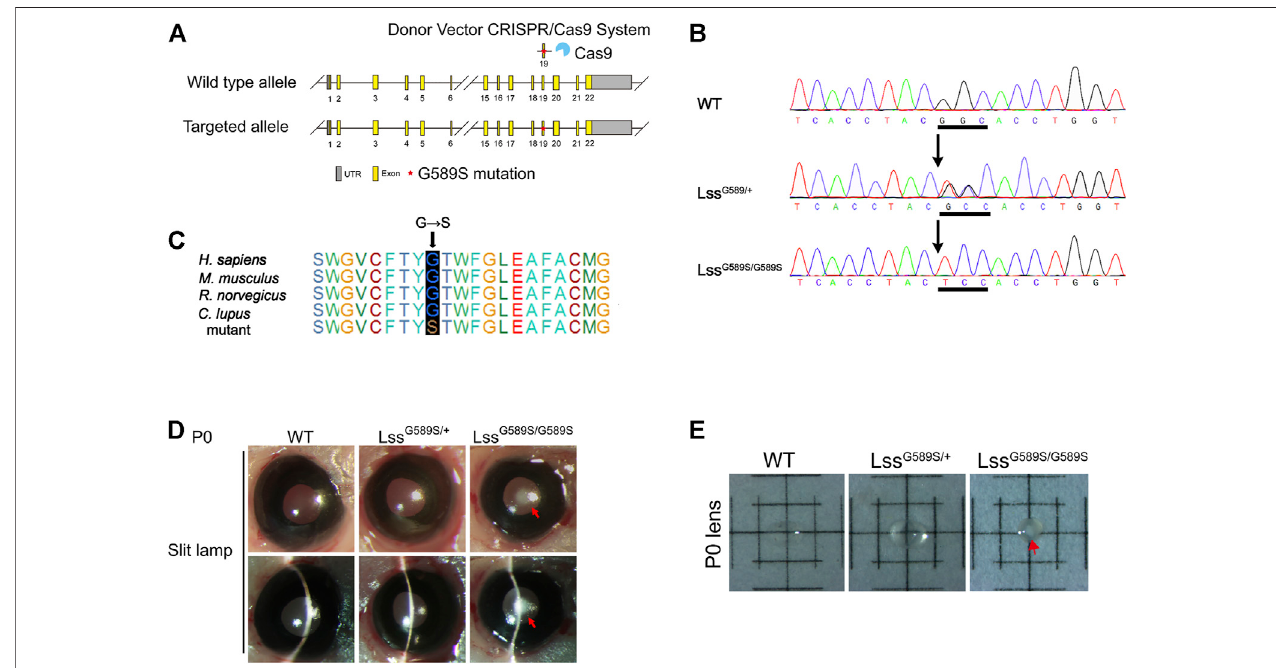
FIGURE 1 | The lens of engineered Lss G589S/G589S mice could recapitulate the phenotype of human congenital cataract. (A) Schematic diagram of Lss G589S knock-in mice generated at exon 19 of Lss via the CRISPR/Cas9 system. (B) Sanger sequencing performed to validate the G589S missense mutation (GGC > TCC) in WT,Lss G589S/+ ,andLss G589S/G589S mice.Underlinedsequencesindicatethechangednucleicacids. (C) TheaminoacidresidueG588inhumanLSSishighlyconserved across species, which is homologous to mouse G589. Blue box refers to the homologous site of LSS G588 in Homo sapiens , Mus musculus , Rattus norvegicus , and Canis lupus . (D) Mouse lens were examined by slit lamp. Red arrows indicated congenital cataract formed in lens of Lss G589S/G589S mice at P0. (E) Lenses were isolated and photographed by a dissecting microscope. Red arrows indicated cataract formed in the lens of Lss G589S/G589S mice at P0.